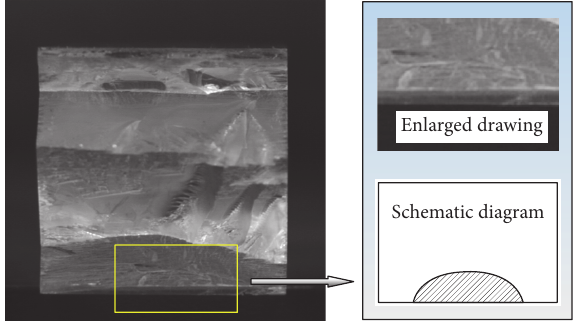
Figure 4: Macroscopic fracture